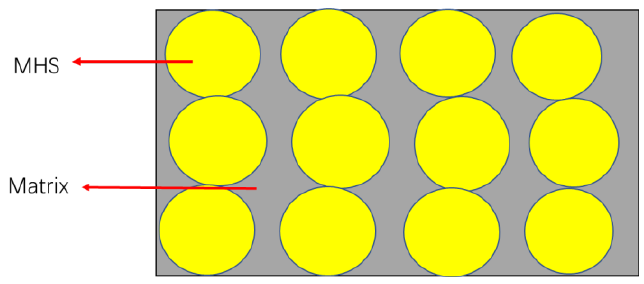
Figure 13. The schematic diagram of MHSC-LS.